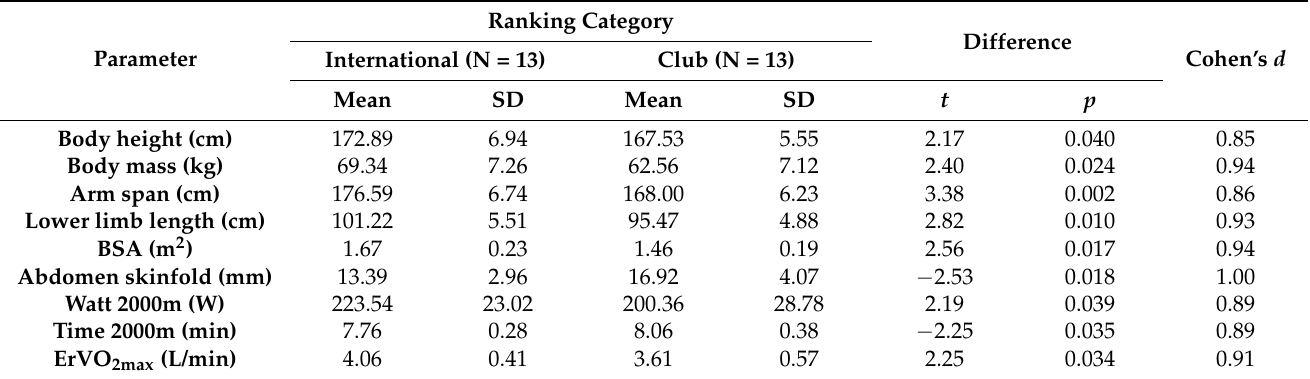
Table 3. Comparison of arithmetic means of older junior female rowers anthropometric, physiological, and motoric parameters depending on the ranking